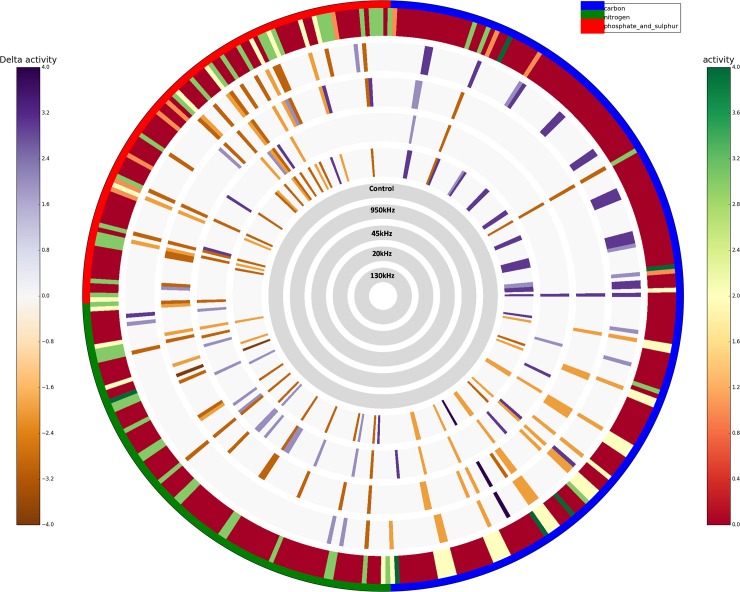
High-throughput metabolic activity in difference mode: The difference with the AV value of control culture is reported when AV≥2; it is grey otherwise; purple indicates a higher activity to; orange colour indicates a lower activity of ultrasound treated samples with respect control.